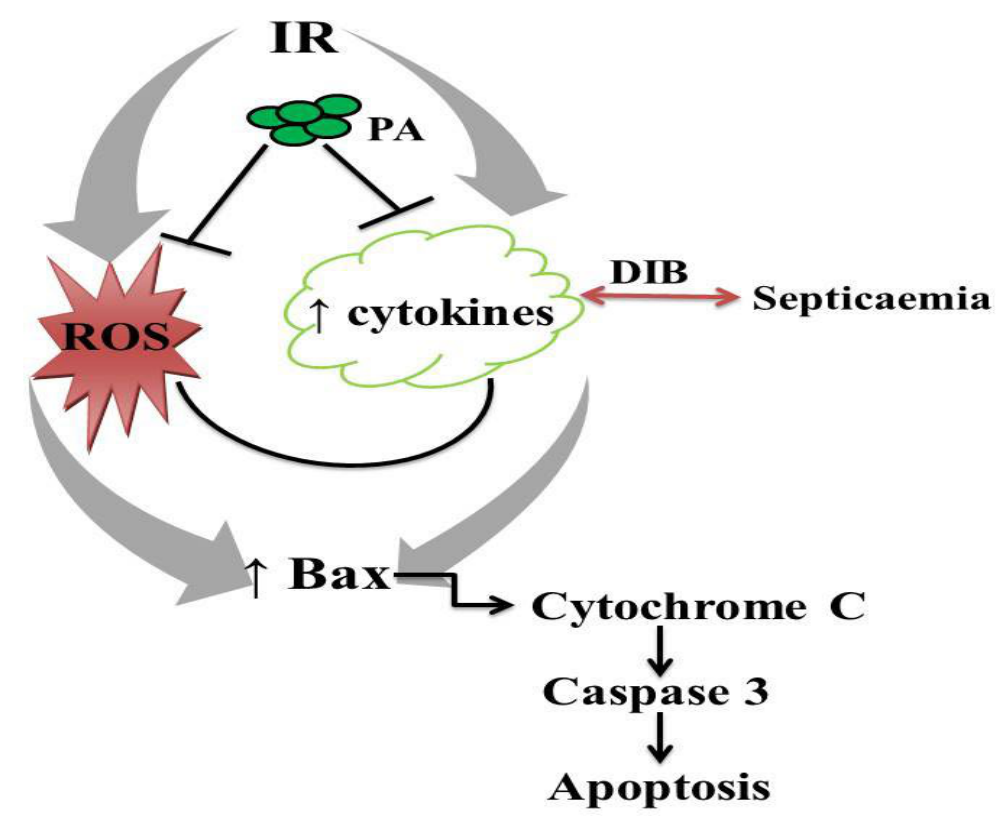
Figure 11. Schematic illustration of the effect of ischemia/reperfusion (IR) and methanolic Phyllanthus amarus leaf extract (PA) on Bax/caspase 3